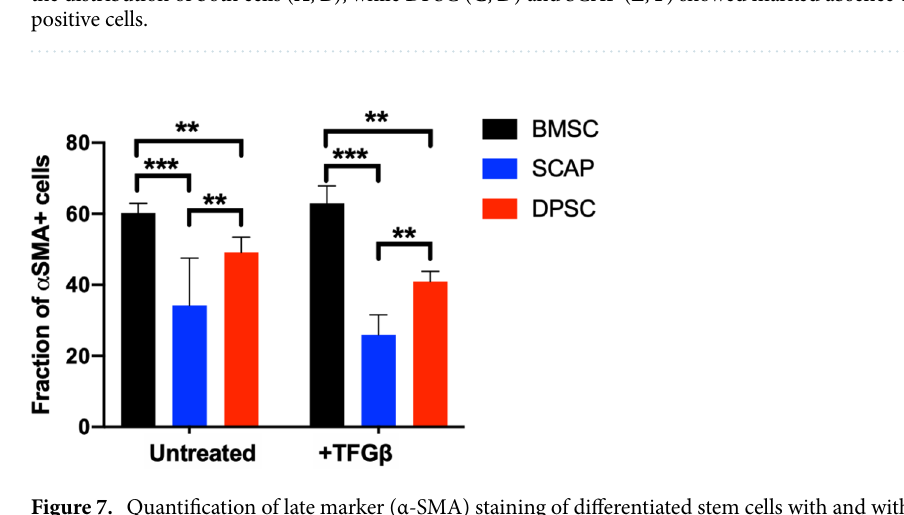
Figure 7. Quantification of late marker (α-SMA) staining of differentiated stem cells with and without pericyte inducer TGF-β. The effect was similar with that of stem cell system involving no TGF-β. BMSC expressed more (α-SMA), followed by DPSC and SCAP (two-way ANOVA, post hoc Tukey, p >